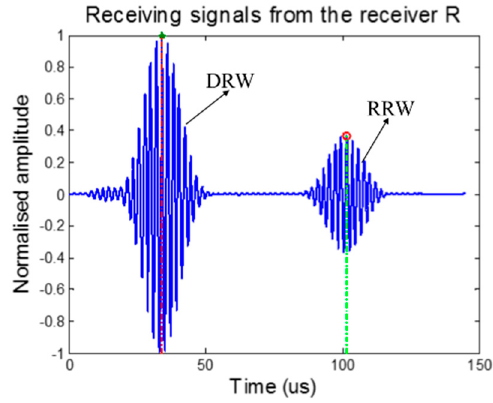
Figure 8. The received signal from simulations. Reproduced with permission from [15], IEEE, 2016.